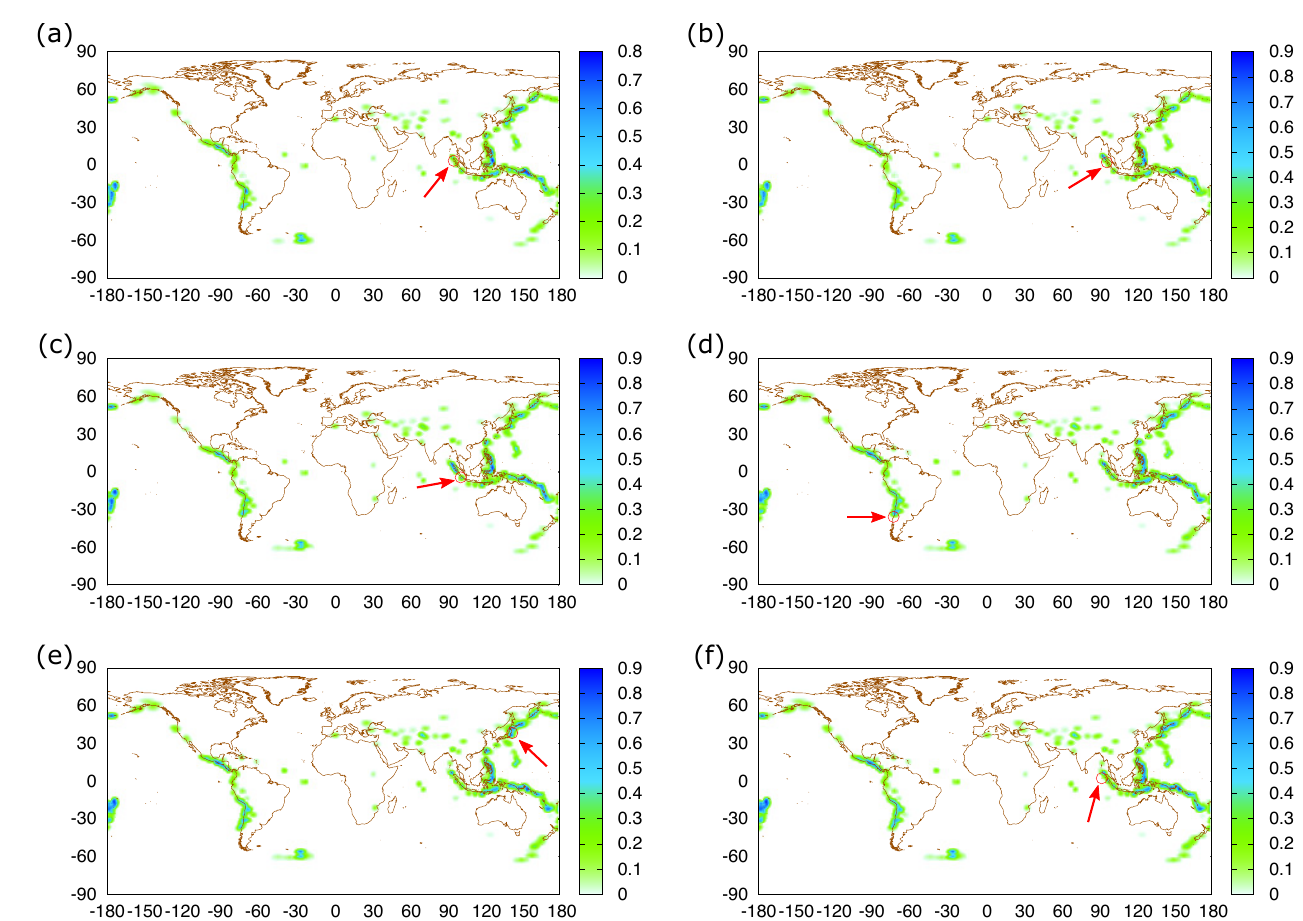
Figure 5. Average EPS maps calculated on the date that β 160 minimizes (see Table 1) for the case of coarse grain radius R = 200 km. Panels ( a – f ) correspond to the M ≥ 8.5 EQs Sumatra–Andaman, Sumatra–Nias, Sumatra–Indonesia, Chile, Tohoku–Japan, and Indian Ocean, respectively (see also Table 2). The epicenters of the latter EQs are depicted by red circles indicated by arrows for the readers’ convenience. The values of (cid:104) EPS (cid:105) at the grid point closest to each epicenter location vary from 7% to